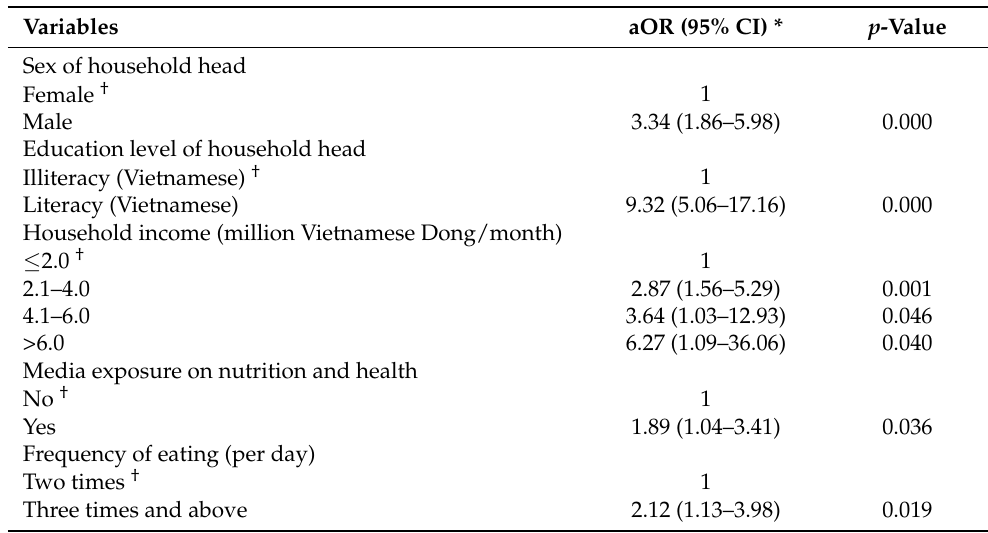
Table 3. Multivariate analysis of factors associated with Khmer household dietary diversity in Tri Ton district.